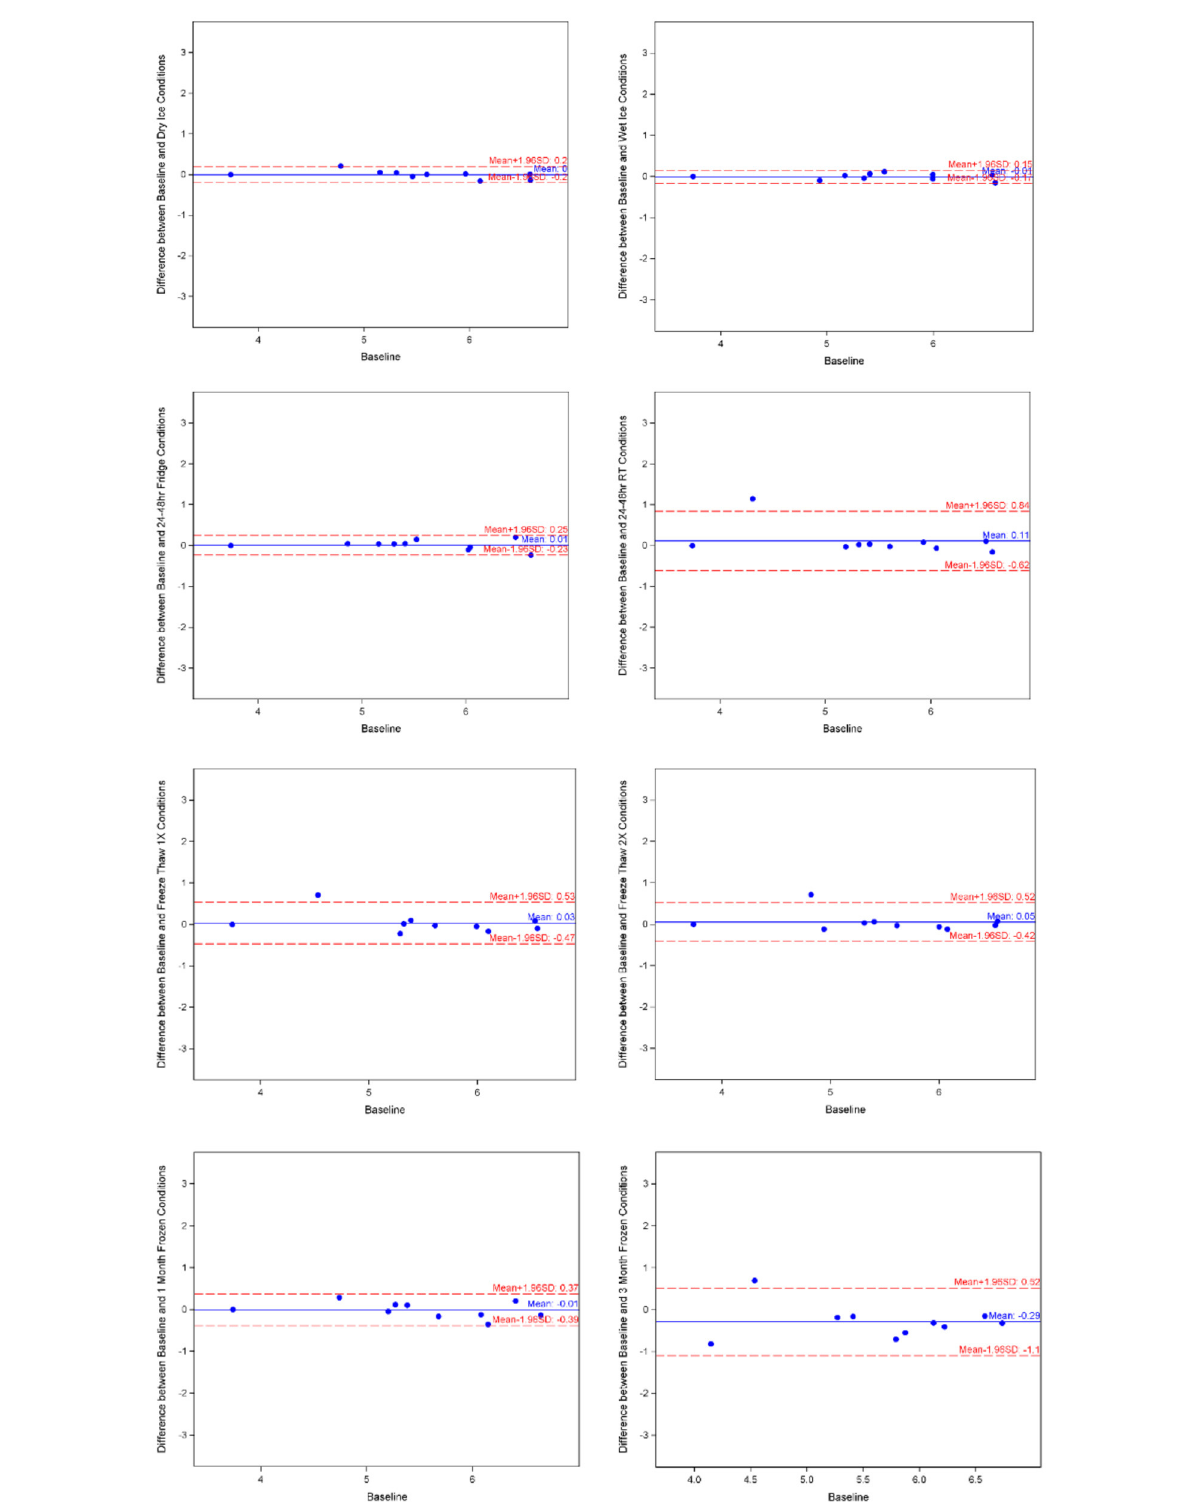
FIGURE4 Hemopexin Bland-Altman charts by experimental condition. Image made with